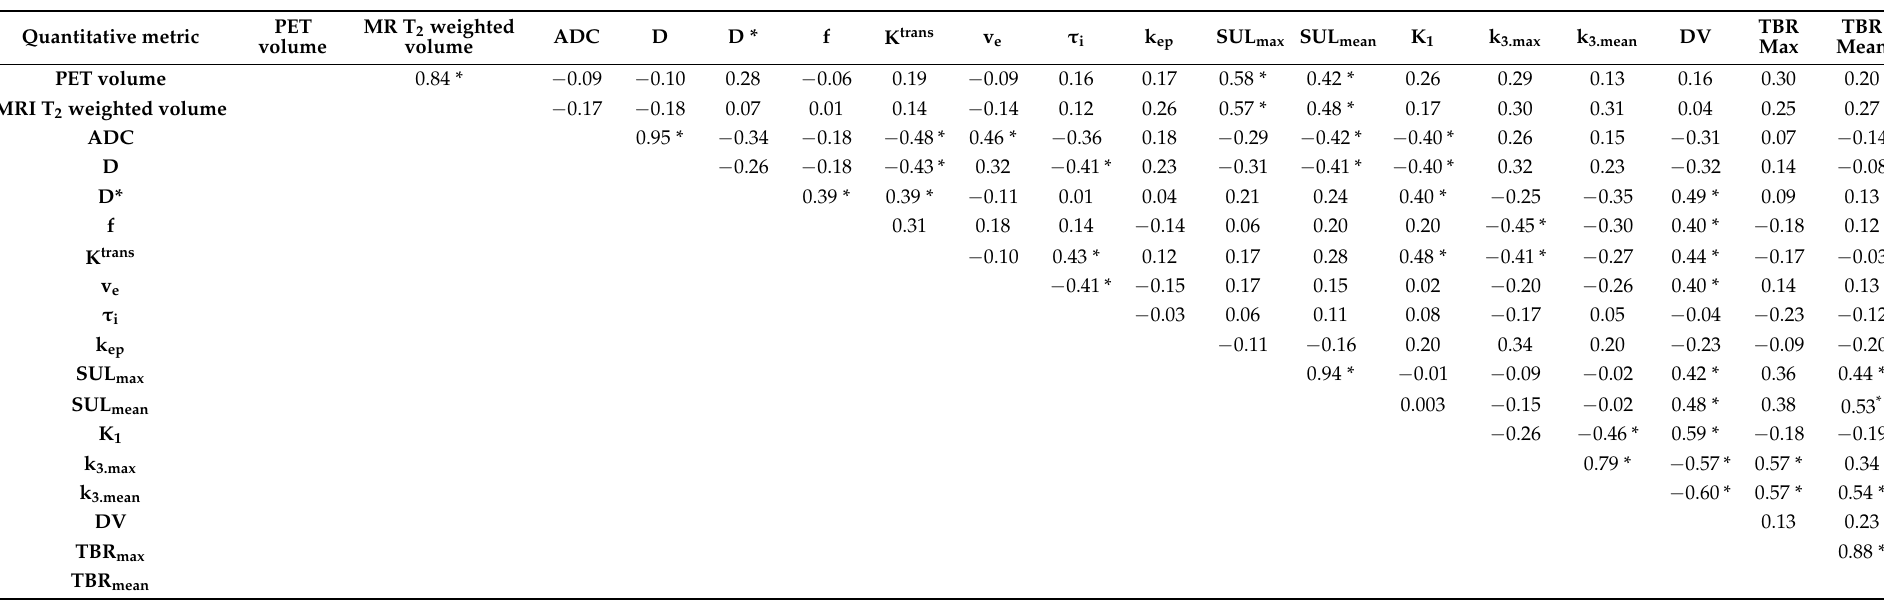
Table 2. Summary of Spearman rank correlation analysis ( ρ ) results between the quantitative metrics derived from multimodality imaging data. Quantitative